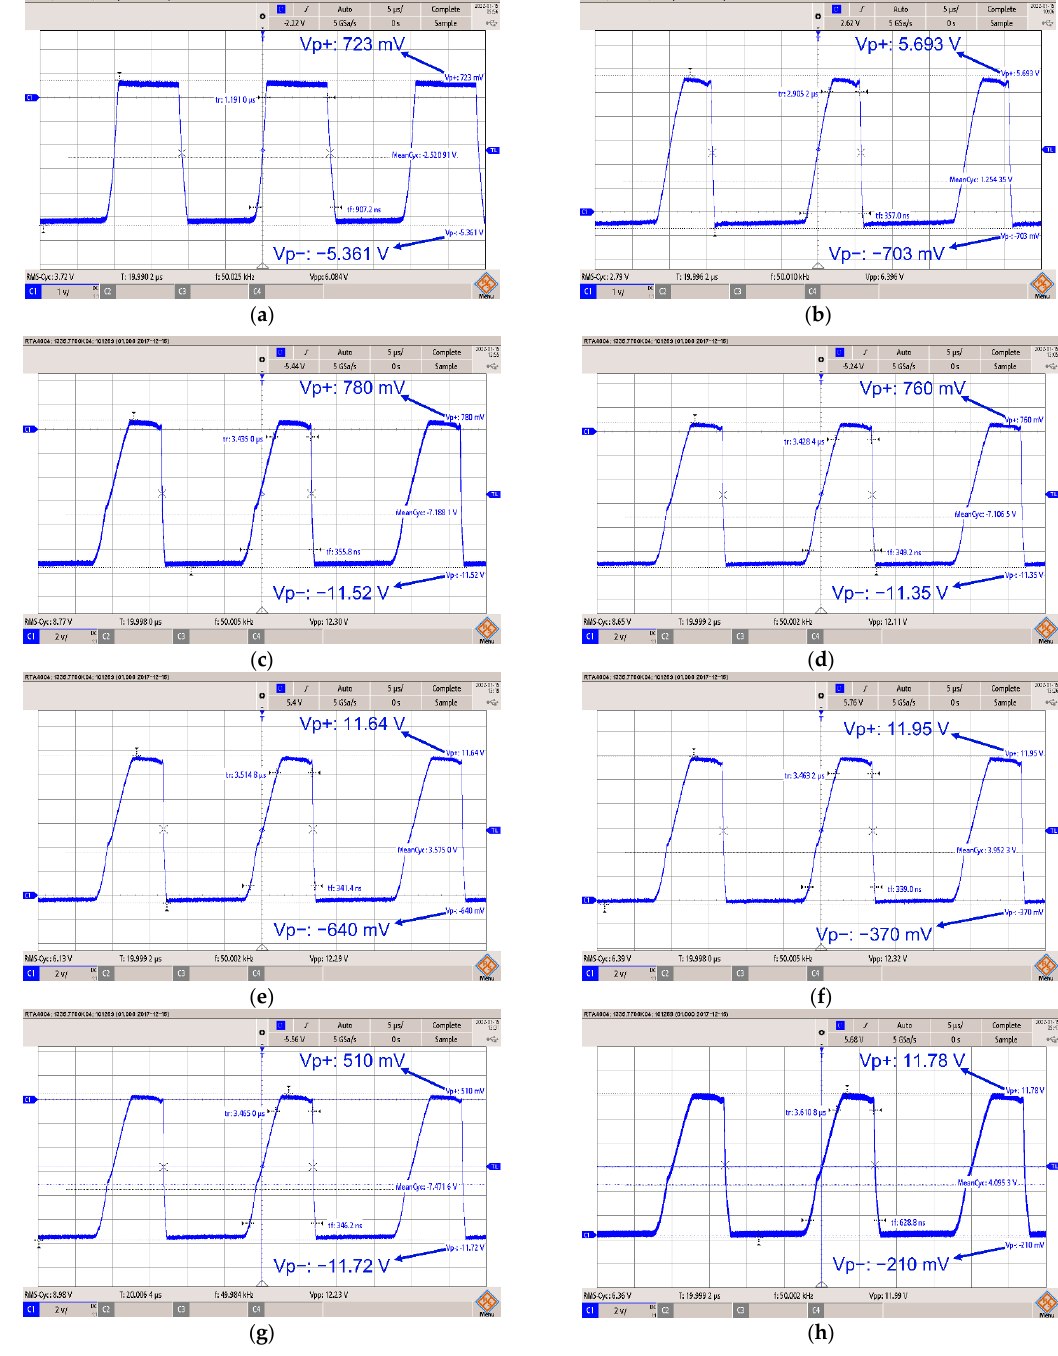
Figure 13. Voltages across diodes at D = 0.5 and V in = 3 V. ( a ) Voltage across D 1 , ( b ) voltage across D 2 , ( c ) voltage across D 3 , ( d ) voltage across D 4 , ( e ) voltage across D 5 , ( f ) voltage across D 6 , ( g ) voltage across D 7 , and ( h ) voltage across MOSFET.